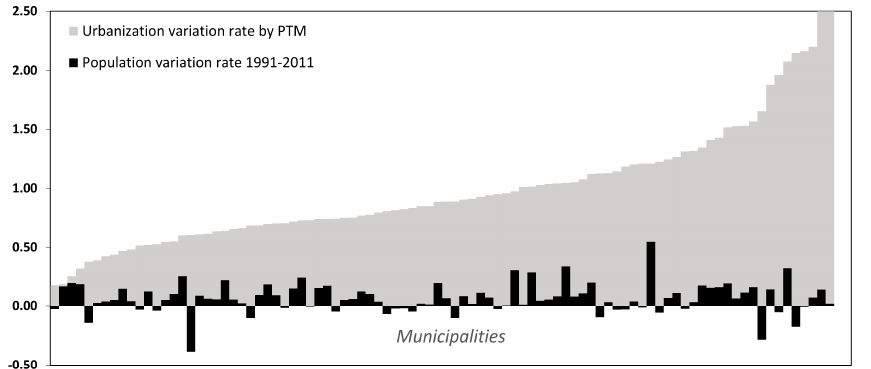
Figure 4. Demographic dynamics for the period 1991–2011 compared to the rate of urban increase per individual municipality according to their planning tools inserted in the Umbria region PTM.